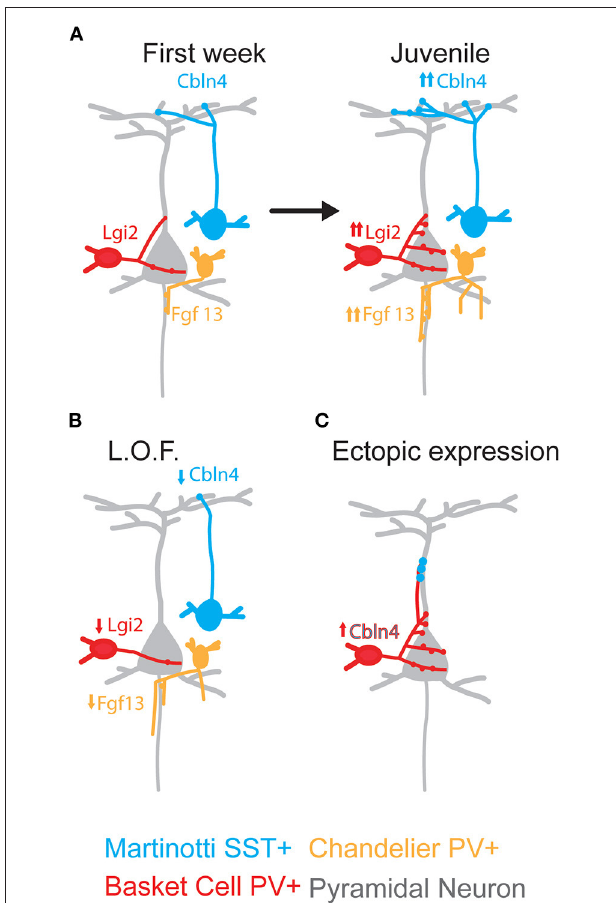
FIGURE 5 | Domain-restricted synaptic molecules. (A) Levels for Cbln4, Lgi2, and Fgf13 increase during development following a IN-type specific molecular program that control domain-restricted synaptogenesis. (B) Synaptic disruption. Loss of the specific synaptogenic molecules during development causes the reduction on the number of synapses onto specific domains of Pyramidal Neurons. (C) Formation of domain-restricted synapses. Ectopic expression of the SST + -specific synaptic molecule Cbln4 in PV + basket cells promotes the formation of synapses onto the dendrites of Pyramidal Neurons. Cbln4, Cerebellin4; Lgi2, Leucine-rich repeat LGI family member 2; FGF13, Fibroblast Growth Factor